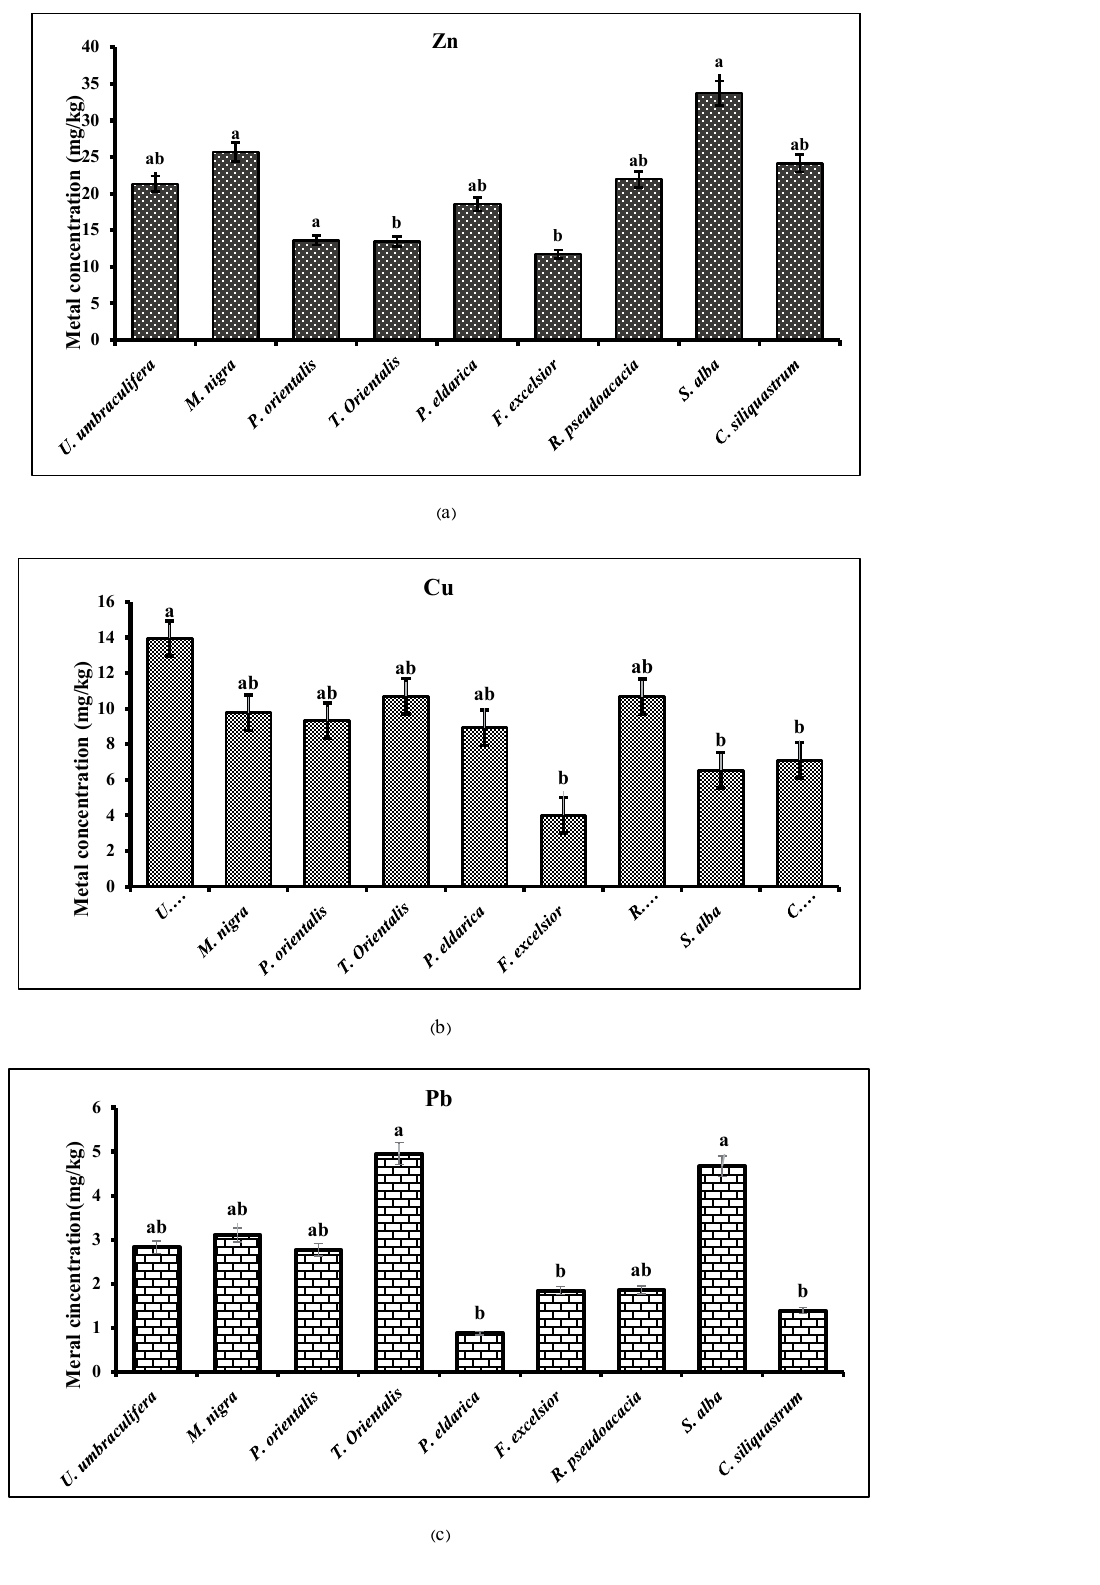
Figure 1- Results of comparing the accumulation of heavy metals zinc (a), copper (b), and lead Figure 1. Results of comparing the accumulation of heavy metals (c) in leaves of different species using 1-way analysis of variance (ANOVA) at a significance level of 95% A: Zinc; B: Copper; and C: Lead in leaves of different species using 1-way ANOVA at a significance level of 95%. Results of BCF, CBCI, and MAI Index Measurements Mortazavi S, et al. Capability of Tree Species in Urban Afforestation to Accumulate Heavy Metals. J Adv Environ Health Res. 2021;